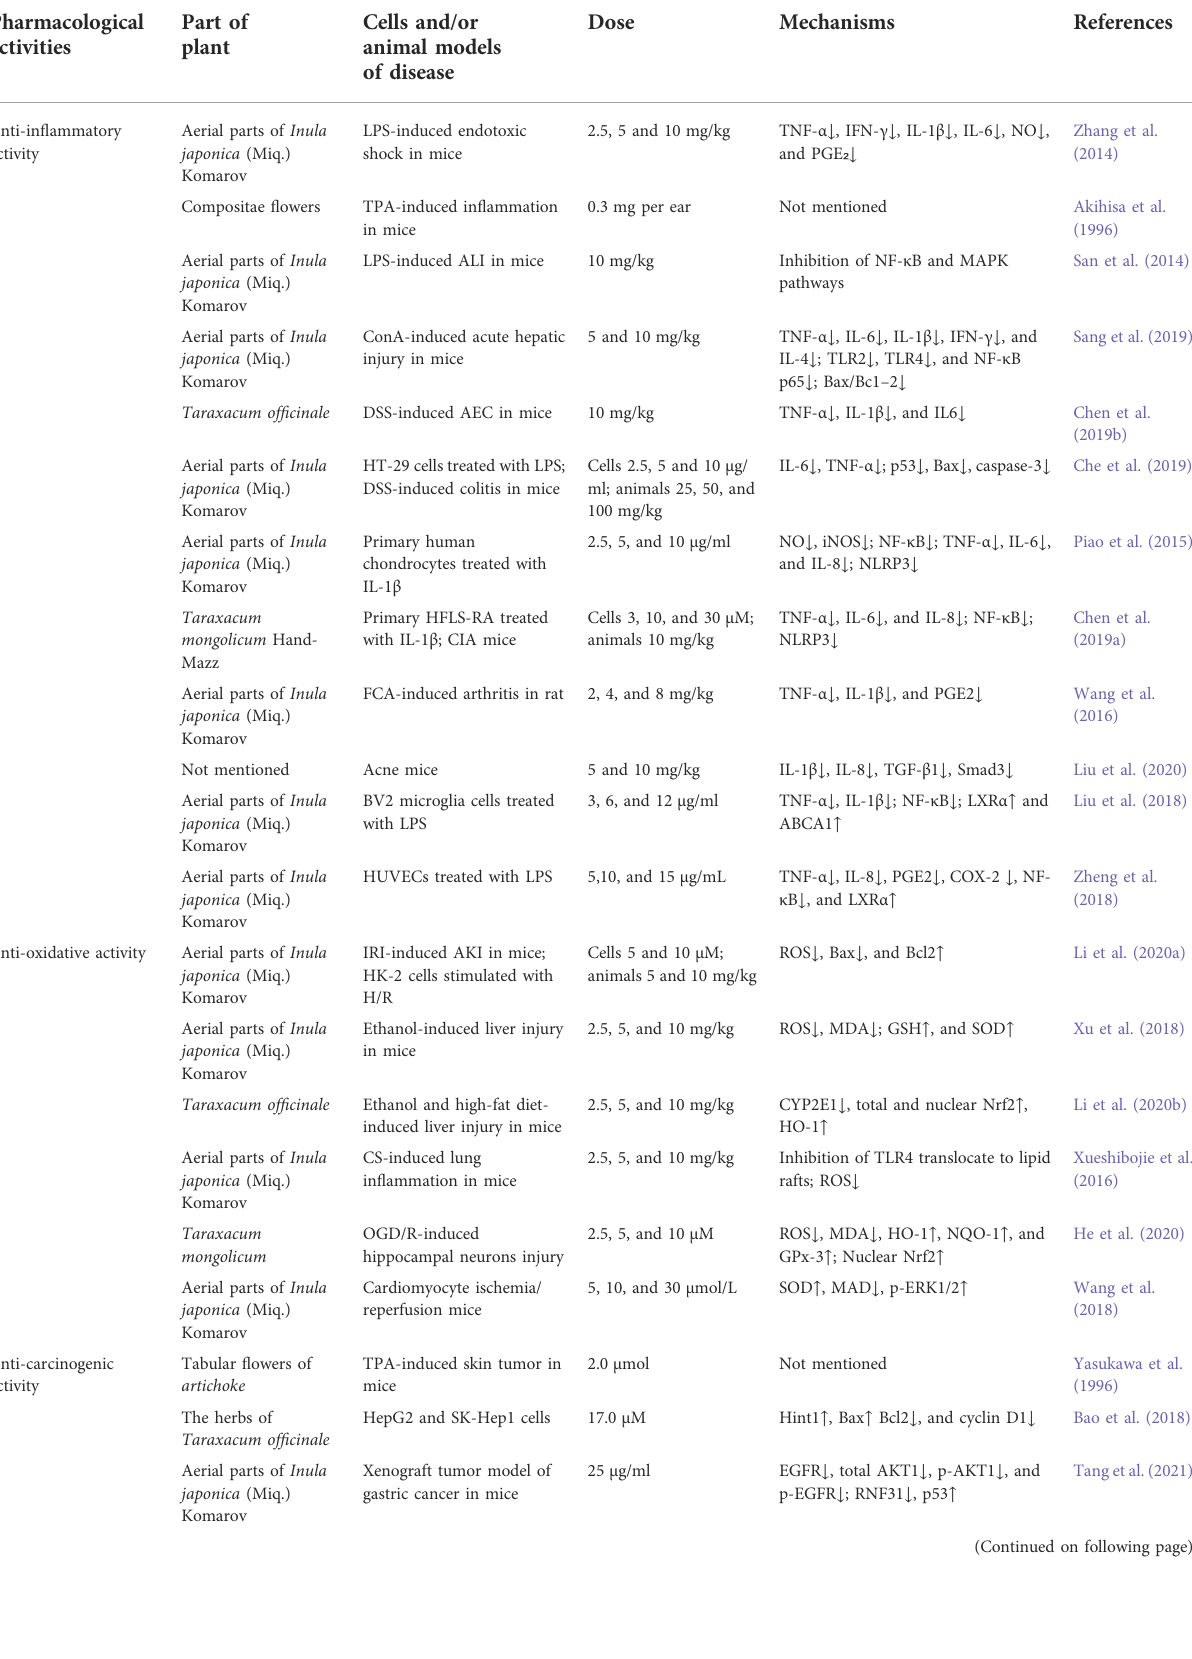
TABLE 2 Pharmacological activities of taraxasterol against diseases ( in vitro and in vivo studies) a